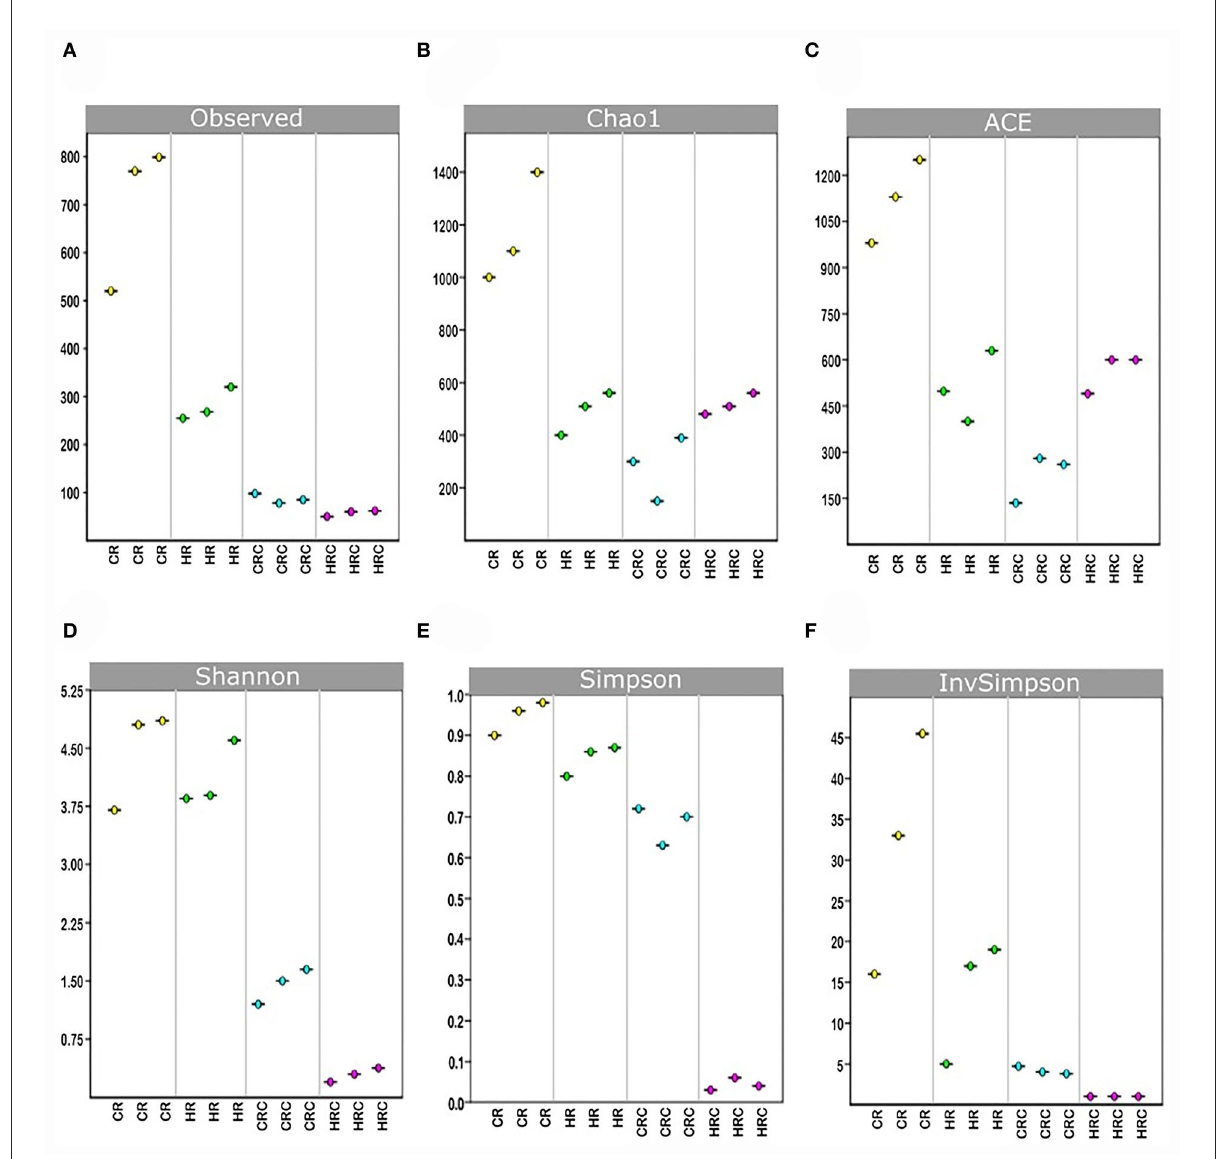
FIGURE4 Indexes of richness. Observed (A) , Chao1 (B) , and ACE (C) and indexes of uniformity Shannon (D) , Simpson (E) , and 1/Simpson (F) , were plotted based on the complete ASV data set determined in fecal samples from control (CR) and hepatoma (HR) rats, and their respective microbiota cultures CRC and HRC. P < 0.01, ANOVA unidirectional and the LSD multiple range test.